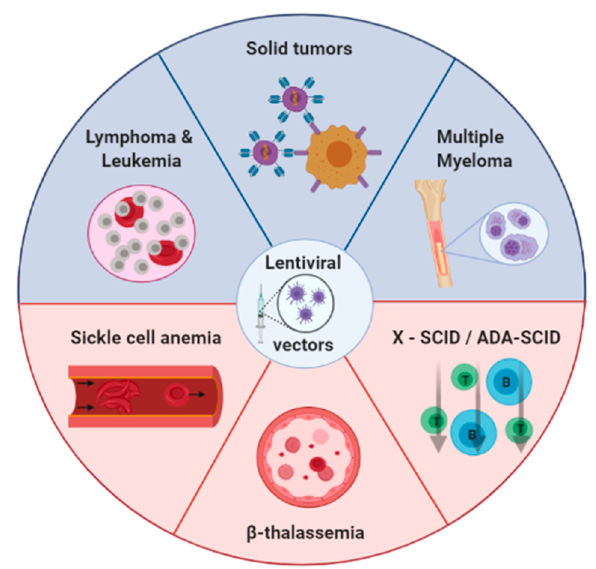
Figure 2. Main diseases with the highest number of active clinical trials using lentiviral vectors up